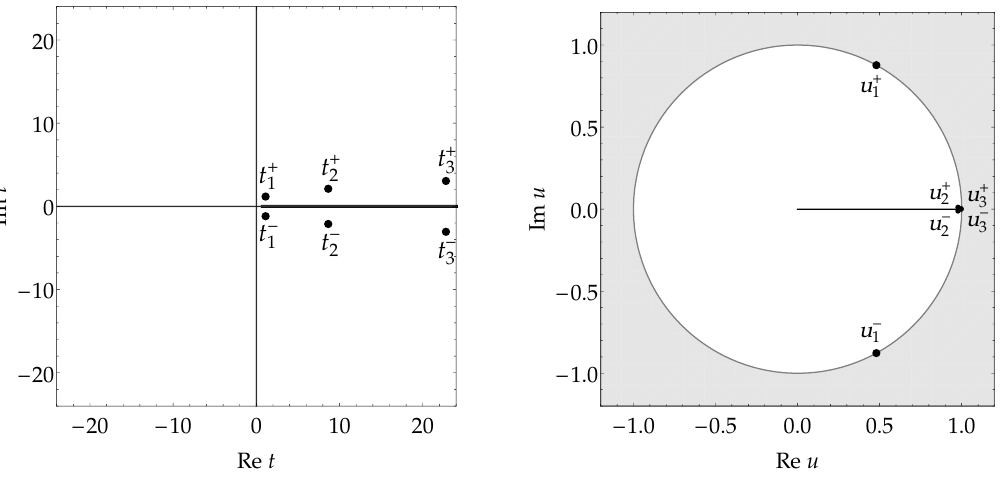
Figure 4 . Position of the three leading singularities of (right) after the conformal mapping of eq. (3.6). The singularities u (cid:6) circle u = 1, though they are very close to j j